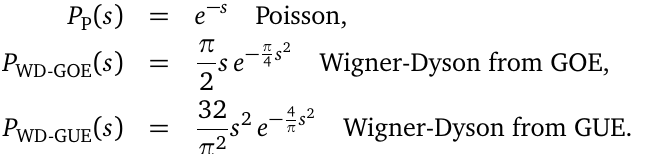
Figure 13: Left: Log Log plot of the rescaled spectral function ˜ c eraged over the GDE ensemble for different system size d = 2 N with N = 6...16. Right: Log Log plot of the spectral function ˜ c ensemble for different system size d = 2 N with N =